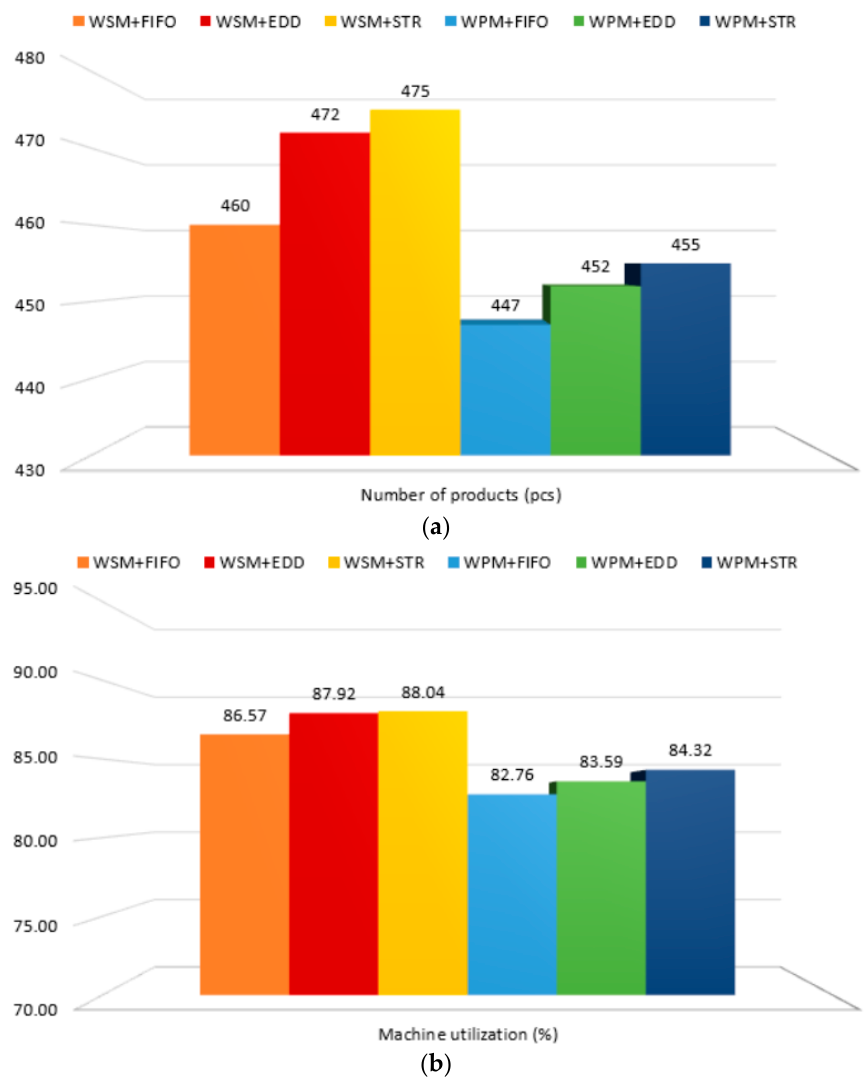
Table 7. Results of multi-criteria optimization based on scalarization for three priority rules.